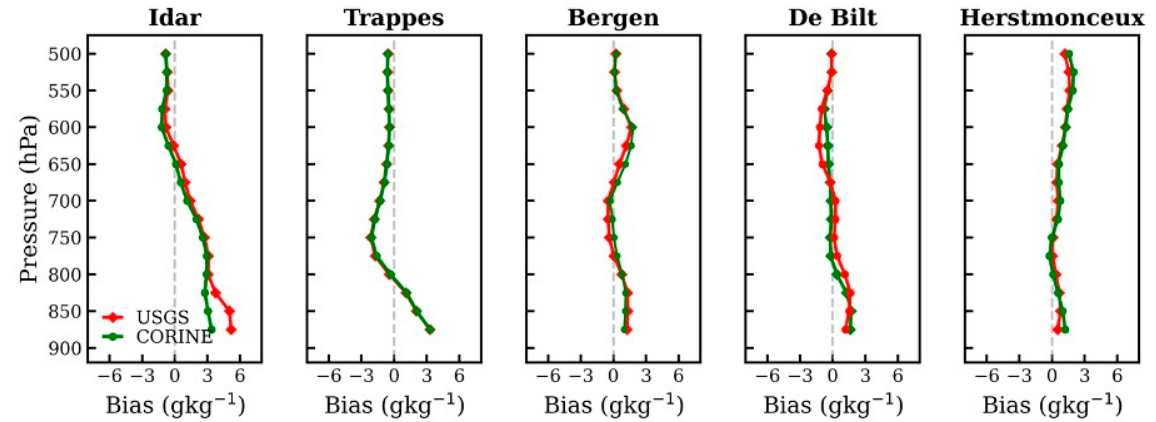
Figure 8. Vertical profile of bias in specific humidity (Q) over five radiosonde stations (Idar, Trappes, Bergen, De Bilt and Herstmonceux) on 18 August 2011 at 12 UTC. The values by WRF_USGS are presented in red colour, and the values by WRF_CLC are given in green colour.